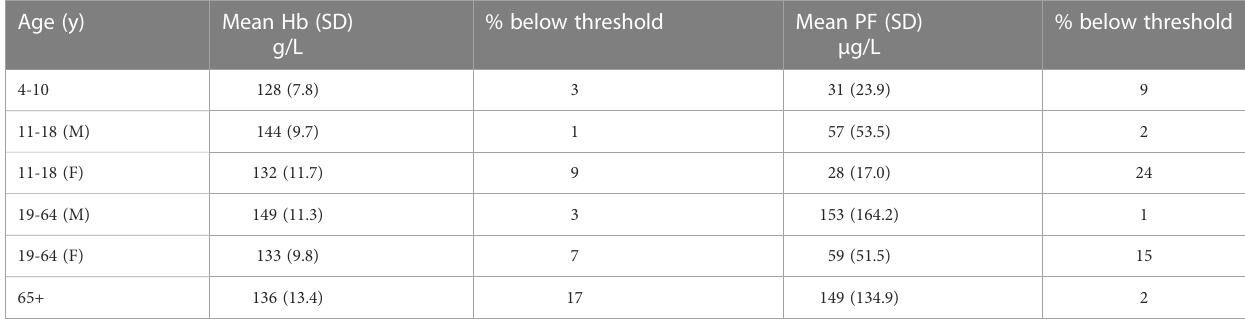
TABLE 1 Haemoglobin (Hb) and plasma ferritin (PF) concentrations in different age groups (NDNS years 7-8, 2014/15-2015/16)